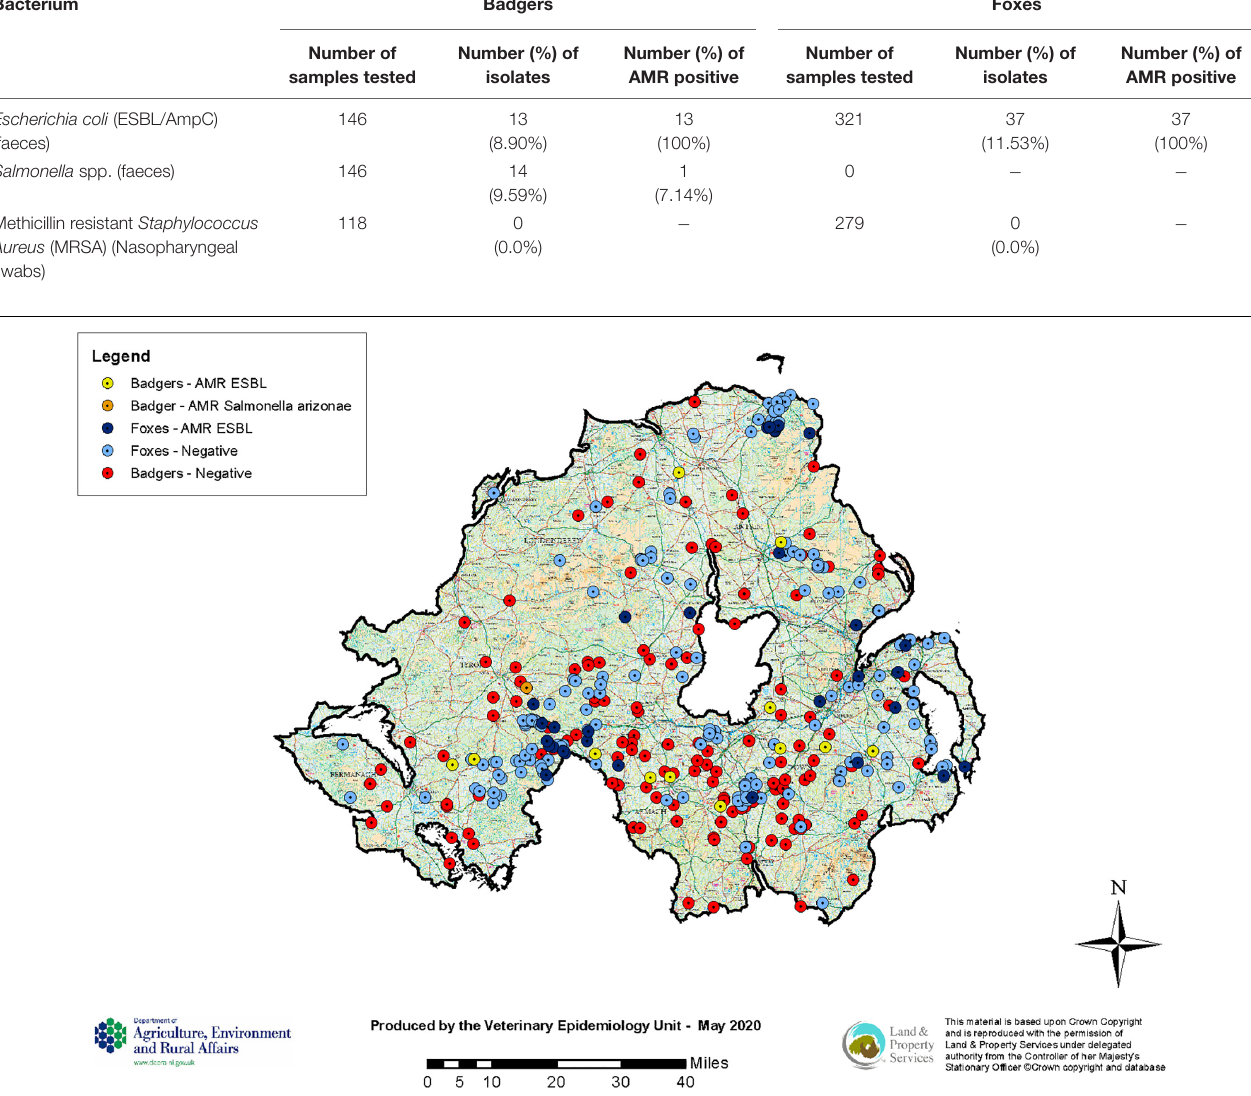
TABLE 1 | Distribution of number of samples, isolates, and AMR positive isolates collected from foxes and badgers (2018–2019).